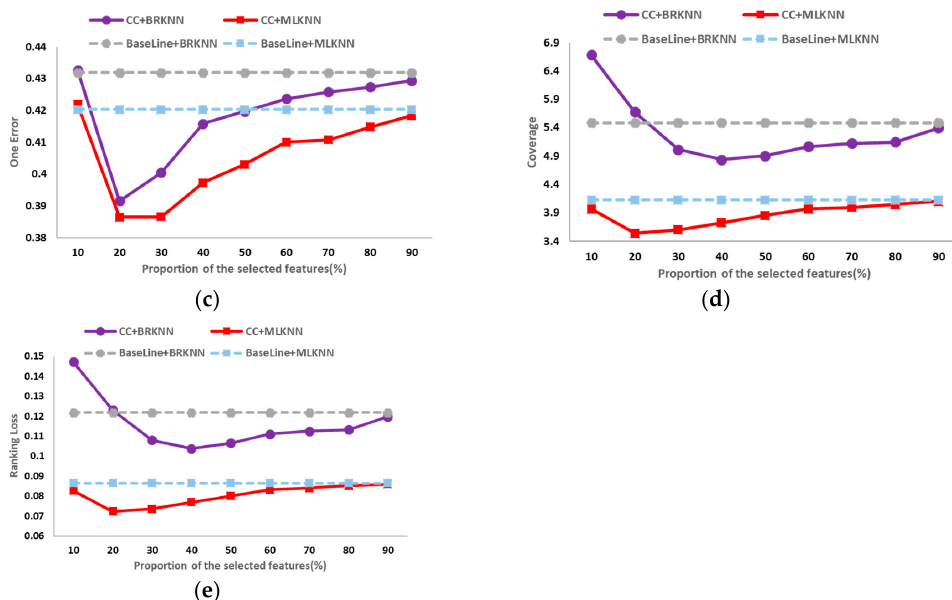
Figure 4. Experimental results on Computers data set. ( a ) Average Precision; ( b ) Hamming Loss; ( c ) One Error; ( d ) Coverage; ( e ) Ranking Loss.